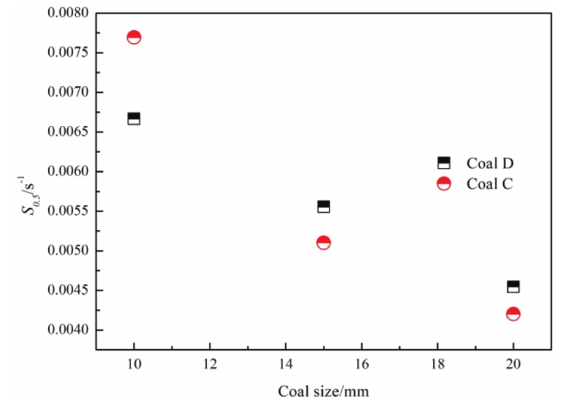
Figure 12: Relationship between S 0.5 and the coal